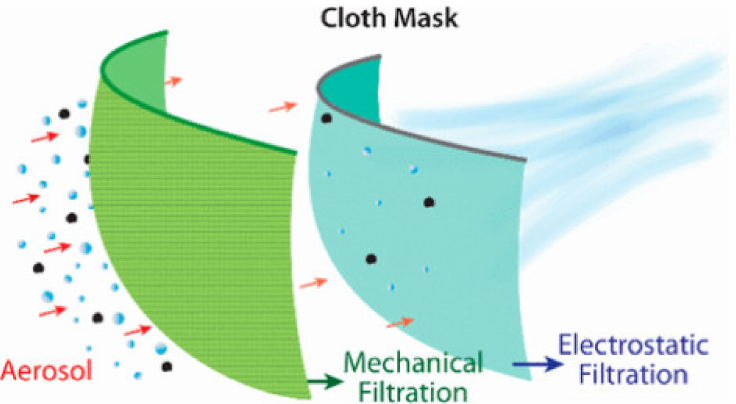
Figure 1. Illustration of filtration mechanism. Reprinted with permission from [71]. Copyright © 2020 American Chemical